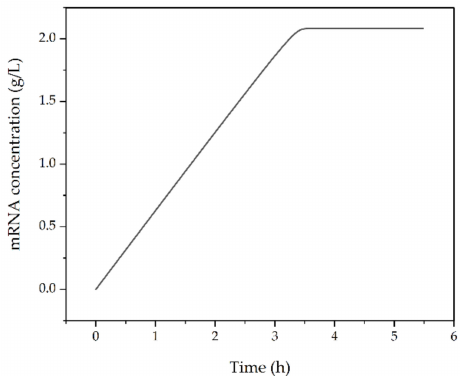
Figure 16. mRNA concentration over process time. Transcription is completed after approx. 5 h.